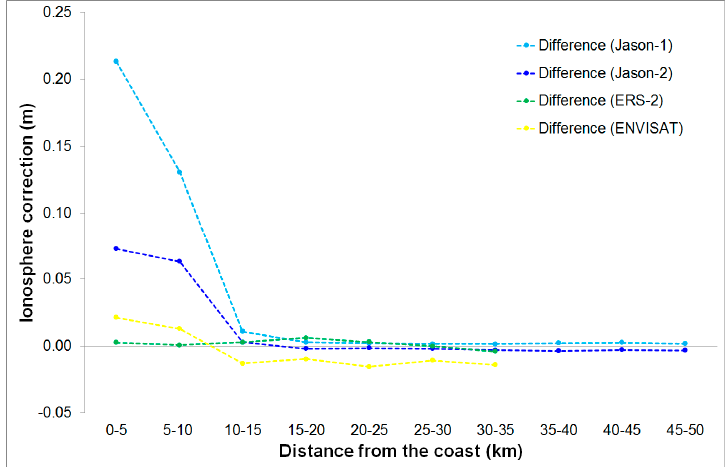
Figure 7. Difference between the ionosphere corrections from GIM and bi-frequency measurements for Jason-1 (light blue), Jason-2 (blue), and Envisat (yellow), and between GIM and Nic09 for ERS-2 (green) over La Rochelle within 50 km of the coast.